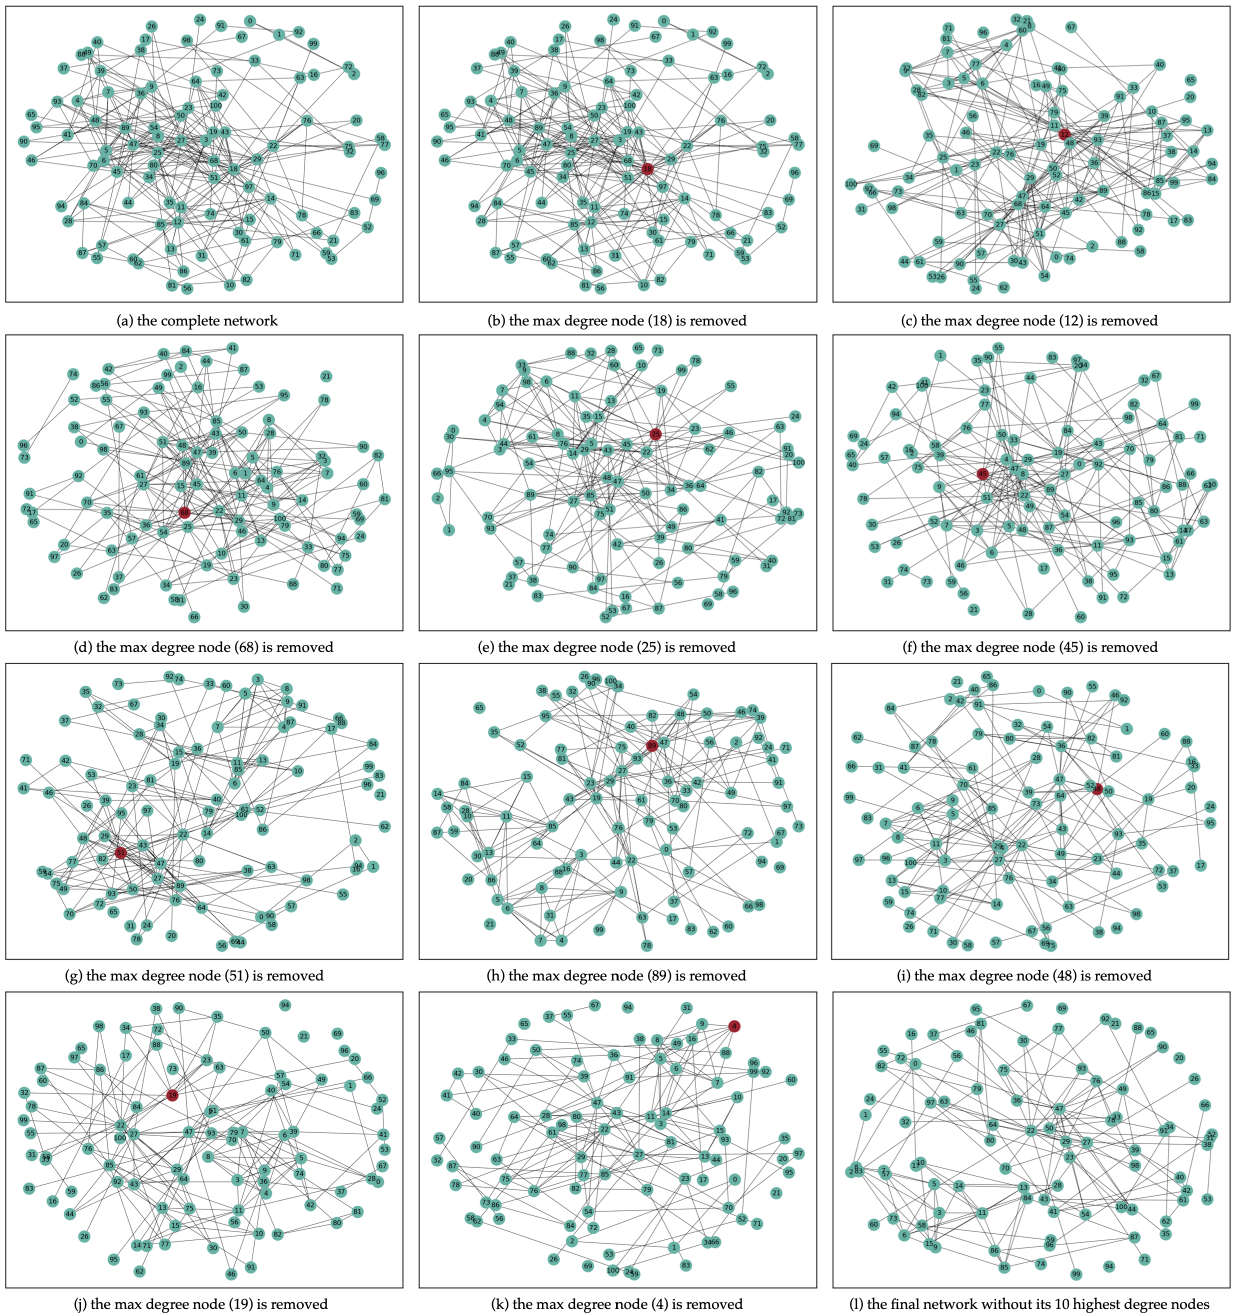
Figure 4. Removal of the 10 most important nodes according to degree centrality in the Meetings network extracted from the Sicilian Mafia operation called Montagna [26]. The first picture ( a ) shows the complete network. Then, at each step ( b – k ), the node with the highest value of degree centrality is marked in red, then removed. The last picture ( l ) shows the network without its 10 most central